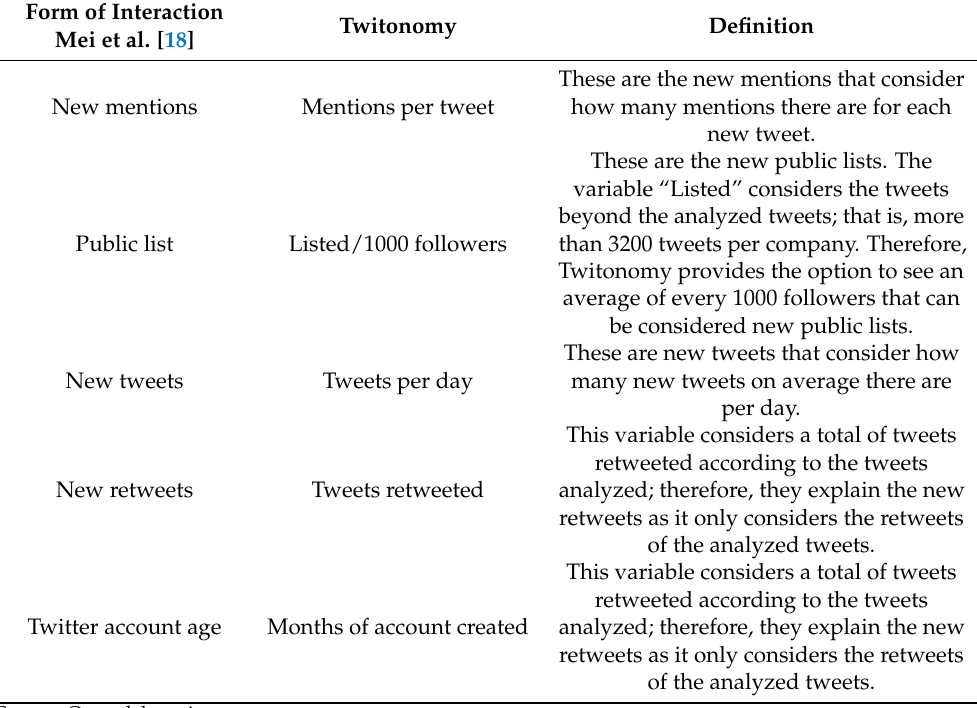
Table 2. The adequacy of interactions of the literature with